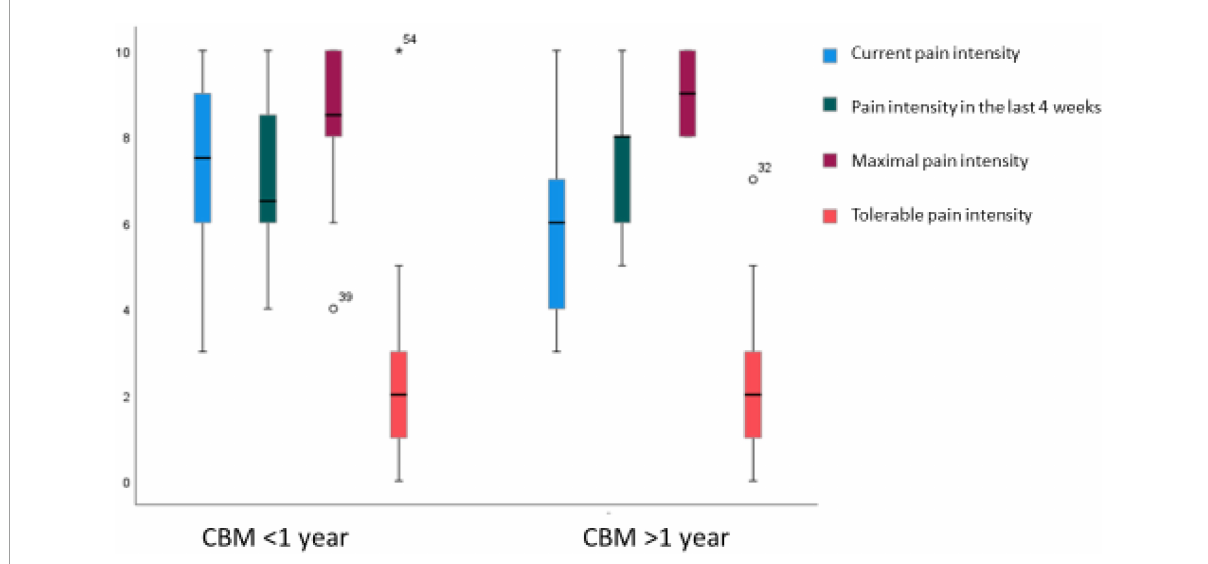
FIGURE2 Distribution of pain intensity at present, in the last 4 weeks, maximal pain intensity, and tolerable pain intensity for groups who received treatment with cannabis-based medicine (CBM) for less vs. more than a